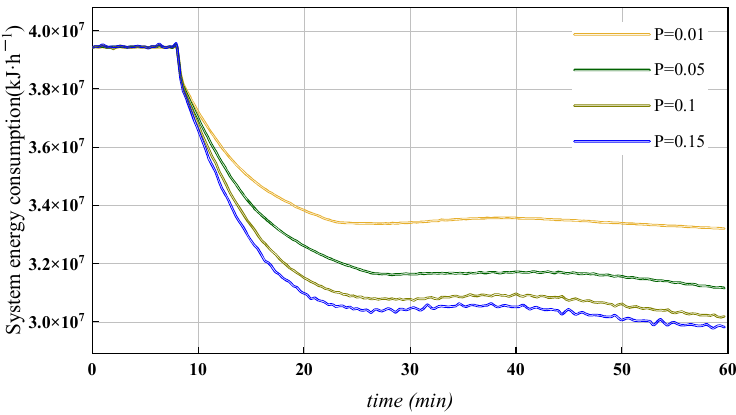
Figure 10. Comparison of different TIC-123 PID parameters’ energy consumption curves. When parameter P of the controller TIC-123 was continuously increased, it did not reduce the duration of energy consumption fluctuation, but it could reduce the energy consumption level after the variable working condition. When P increased to more than 0.15, there was a sawtooth fluctuation in the stationary phase of energy consumption; increasing P further was not conducive to smooth control. Parameter P of TIC-125 was optimized; Figure 11 presents its energy consumption curves.